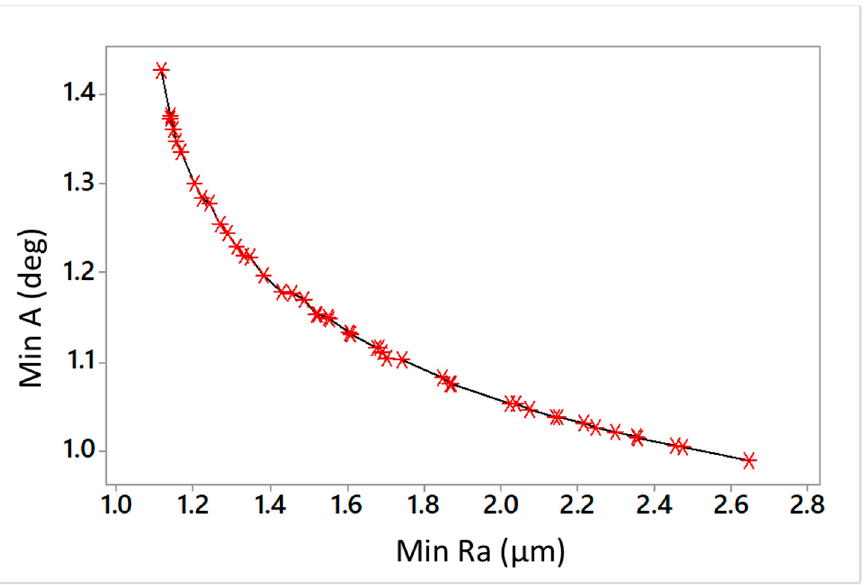
Figure 9. Non-dominated, “Pareto optimal” solutions, obtained by MOGWO algorithm for solving the CO 2 laser cutting problem. Table 4. Recommended optimal solutions for minKA and minRa by MOGWO algorithm. Sol. No.